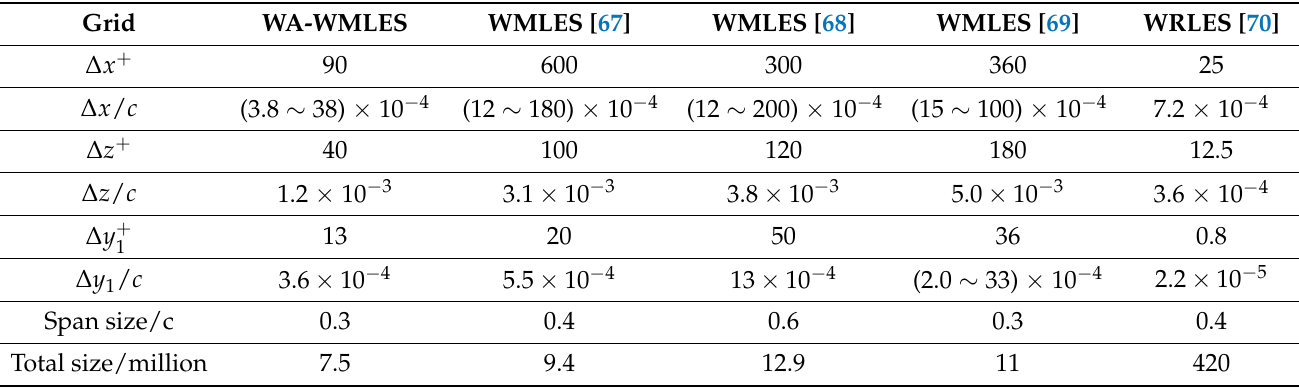
Table 3. Grid resolution for the NASA hump flow simulations, in both wall and chord units. The wall unit is normalised by the kinematic viscosity over the friction velocity. All data are evaluated at the inflow flat-plate turbulent boundary layer, while the subscript 1 denotes the first wall-normal mesh spacing.